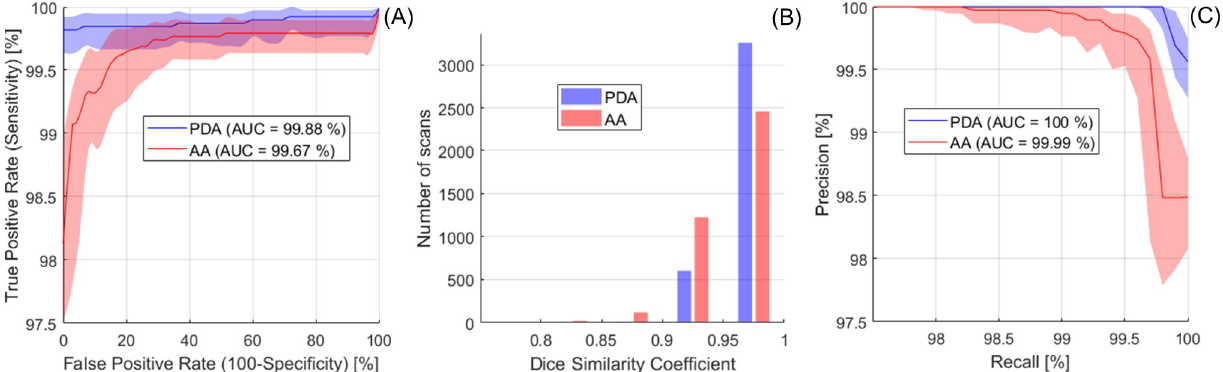
Algorithm testing: Automated aorta localization